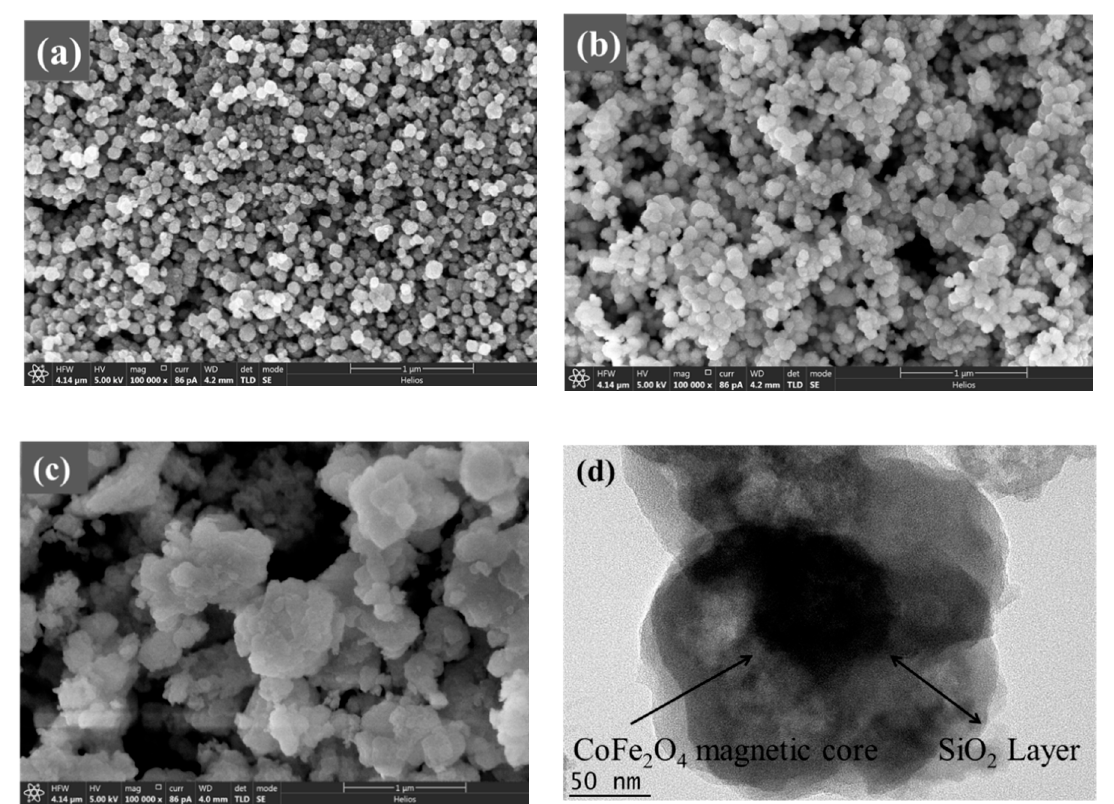
Figure 2. Scanning electron microscopy (SEM) images of CoFe 2 O 4 ( a ), CoFe 2 O 4 @SiO 2 ( b ), and CoFe 2 O 4 @SiO 2 -EDTA ( c ); transmission electron microscopy (TEM) image of CoFe 2 O 4 @SiO 2 -EDTA ( d ).